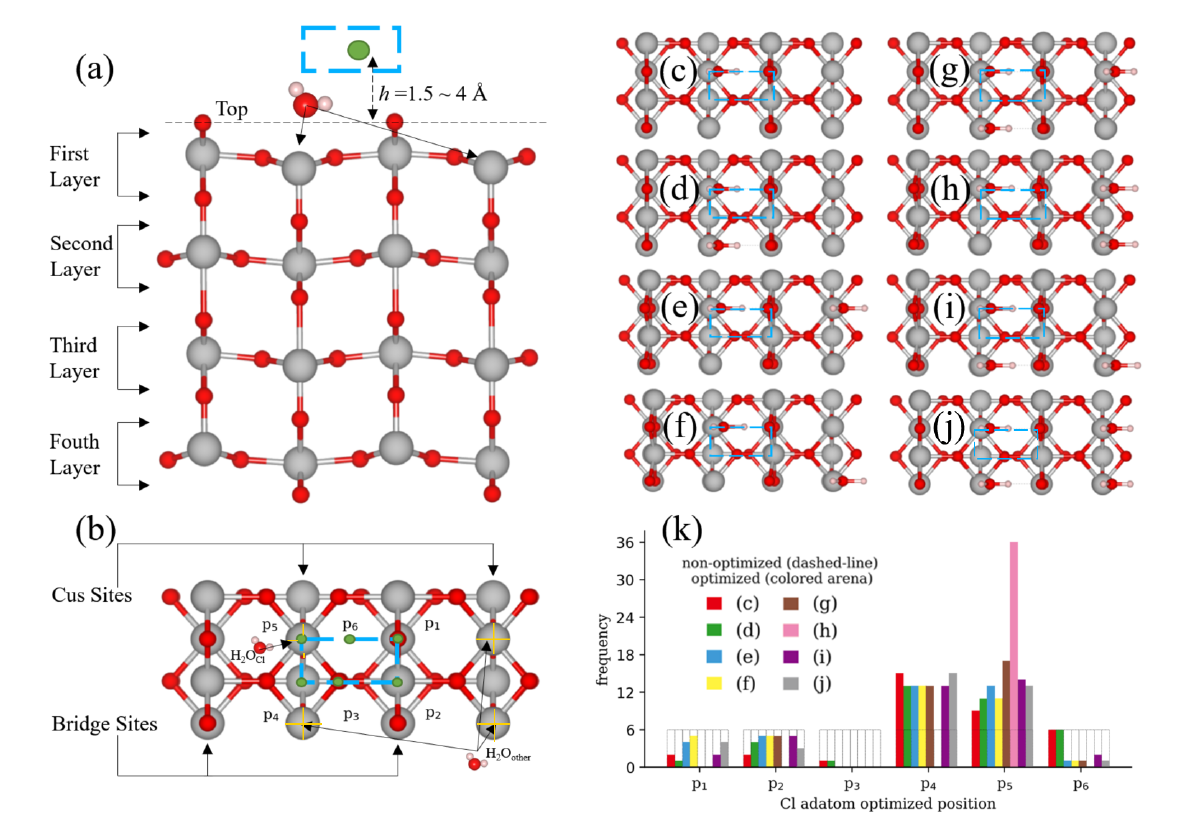
Figure 1. TiO 2 surface models of Cl adatom on the rutile (110) surface with H 2 O adsorbate. ( a ) Side view and layer definition of the TiO 2 surface models used in this research; ( b ) top view and adsorption sites atop the slab are defined as cus and bridge sites. The yellow crosses marked on the Ti atoms indicate the positions of H 2 O adsorbates. The green spheres represent the initial positions of Cl adatom along the blue dashed rectangular line from p 1 to p 6 . H 2 O Cl is the water at the p 5 position; other H 2 O adsorbates are named H 2 O other . This study considers various surface structures of rutile TiO 2 (110) with attached H 2 O adsorbate, as depicted in Figure ( c – j ). These structures include a surface with one water molecule ( c ), structures with two water molecules ( d – f ), three water molecules ( g – i ), and a structure with four water molecules ( j ). The statistics of optimized Cl adatom positions are shown in Figure ( k ); the colored bars correspond to the surface structures ( c – j ), while the empty black rectangular bars depict the non-optimized Cl adatom